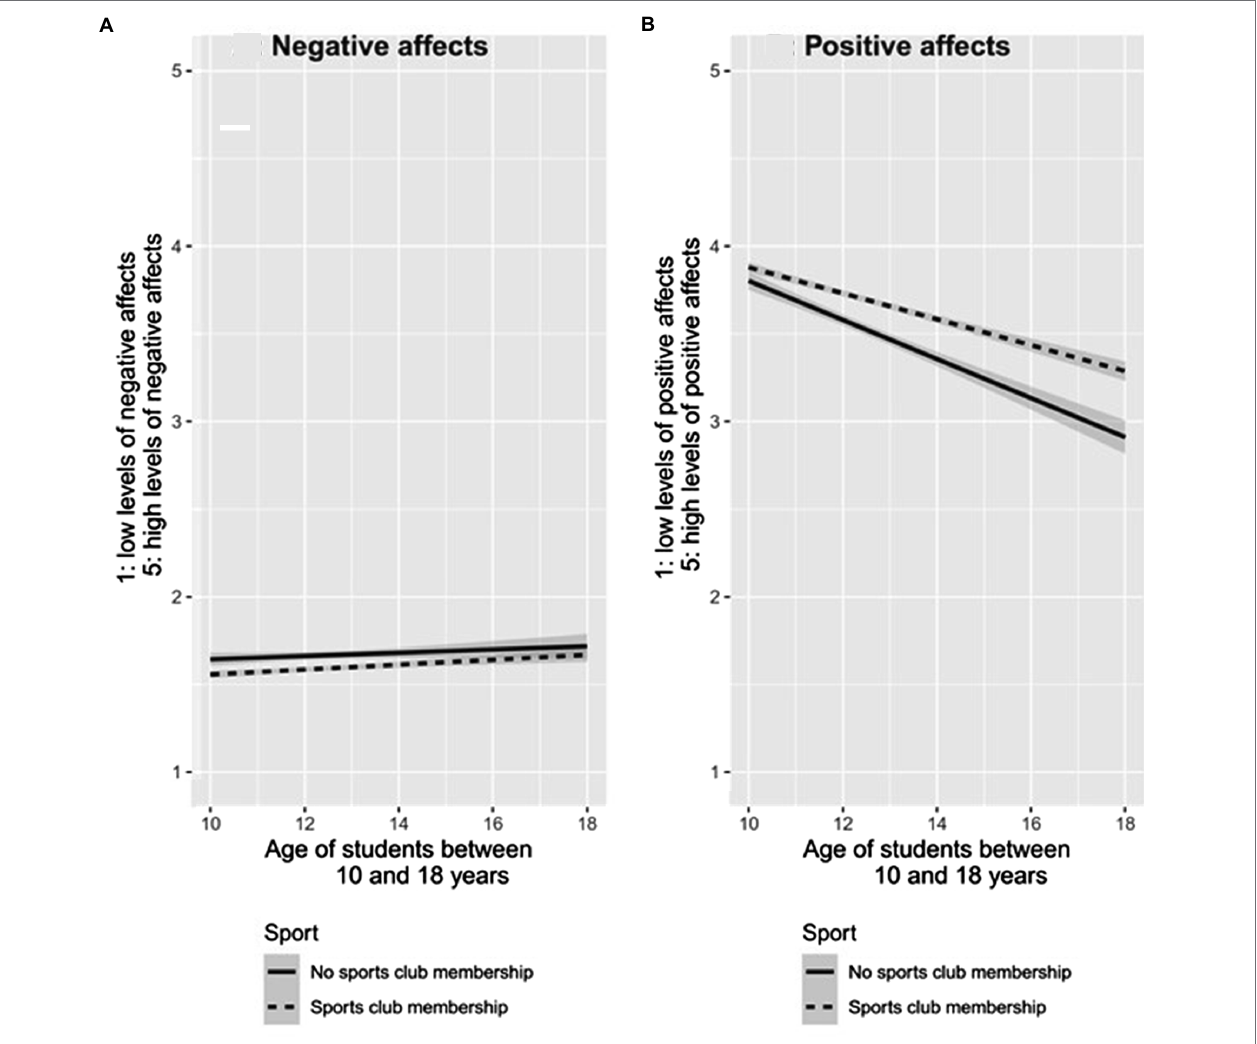
FIGURE 1 | Negative and positive affects along sports club membership and age of adolescents. The left panel (A) depicts negative affect-related results, and it indicates a significant main effect of the sports club membership. The right panel (B) depicts the main effect of the sports club membership on positive affects, as well as its interaction with the age of the students showing that late adolescents experience more positive emotions than early adolescents if they belong to a sports club (compared to the lack of